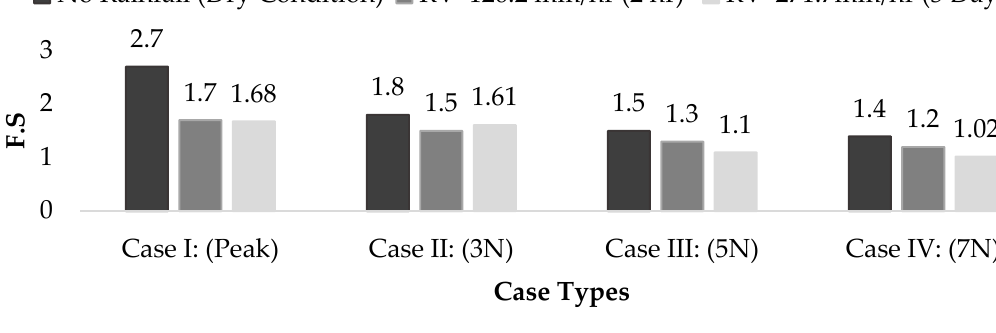
Table S1: Determination of van Genuchten (1980) fitting